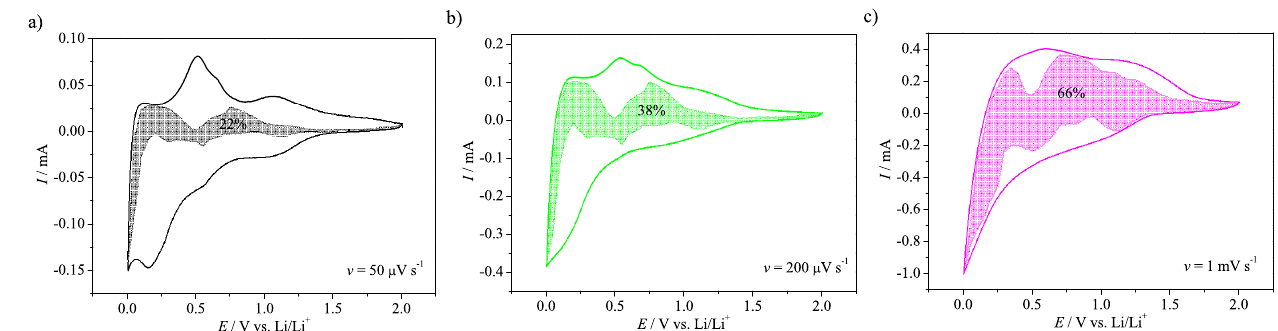
Figure 5. The fraction of the current response at ( a ) 50 µ V s − 1 , ( b ) 200 µ V s − 1 , and ( c ) 1 mV s − 1 sweep rates regarding to the charge storage contribution. The shaded regions are associated with the capacitive currents.